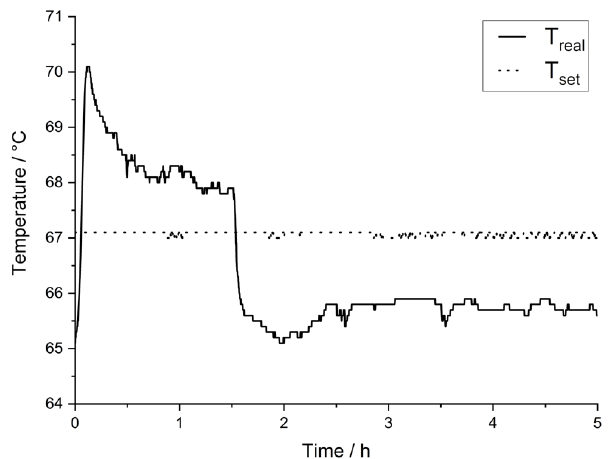
Figure 3. Detailed temperature curve for leaching at T: 65 °C; solid conc.: 50 g/0.1 L. In Figure 4 the corresponding curves for leaching experiments at different constant temperatures are compared. The chosen temperatures were 11 °C, 25 °C, 45 °C, 65 °C and 80 °C. One curve shows the temperature for leaching without temperature maintenance by a thermostat. Figure 4. Temperature curves for leaching at different temperatures (dotted lines: thermostat; thick lines: reactor); solid conc.: 50 g/0.1 L. Apparently, the observed temperature peak occurring at the beginning of the leach- ing experiments is present at all investigated leaching temperatures. At higher tempera- tures, the height of the peak, i.e., the temperature increase due to the reaction of the added H 2 O 2 , is smaller due to the already higher temperature level of the surrounding leaching solution. Another observation is that at higher temperatures, the temperature peak occurs earlier. This, in conclusion, suggests—as the dosage rate of H 2 O 2 is the same in all cases— that the necessary oxidation potential to initiate the reaction is reached earlier at higher temperatures because of the improved reactivity of the leaching reactants. Again, all the curves show a temperature drop to the respective initial temperature level with the end of the H 2 O 2 -dosage after approx. 1.5 h.